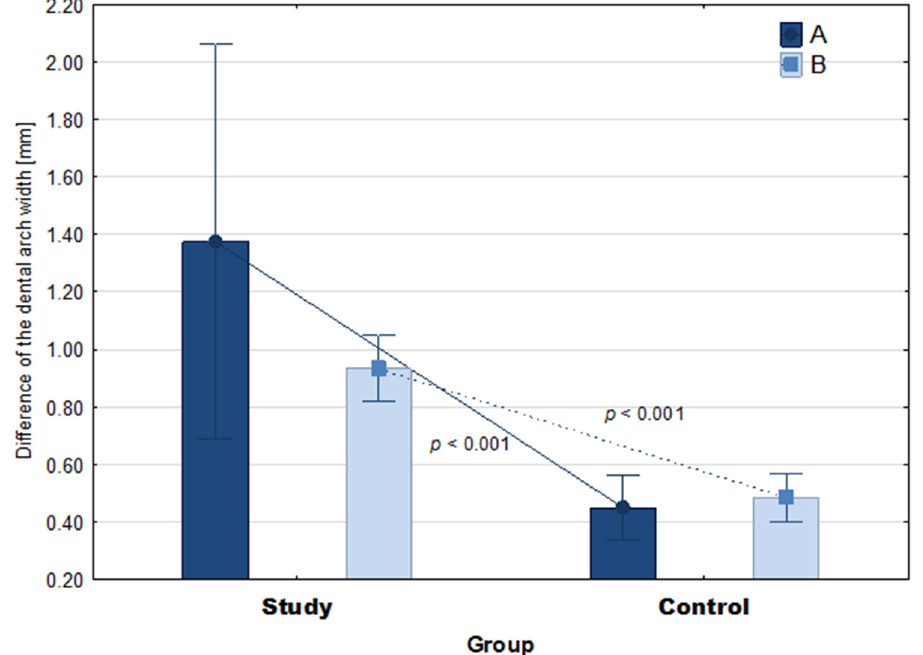
Figure 4. The 10-month mean difference in jaw parameters in the groups. The p -value relates to the Figure 4. The 10 ‐ month mean difference in jaw parameters in the groups. The p ‐ value relates to the Mann-Whitney U test and Student’s t -test. Whiskers show 95% confidence intervals. A—anterior Mann ‐ Whitney U test and Student’s t ‐ test. Whiskers show 95% confidence intervals. A—anterior width of the upper arch, B—posterior width of the upper width of the upper arch, B—posterior width of the upper arch.